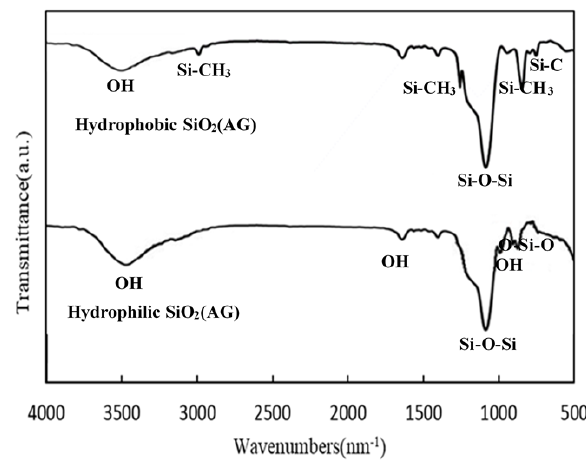
Figure 3: FTIR spectra of hydrophobic/ hydrophilic SiO 2 (AG)